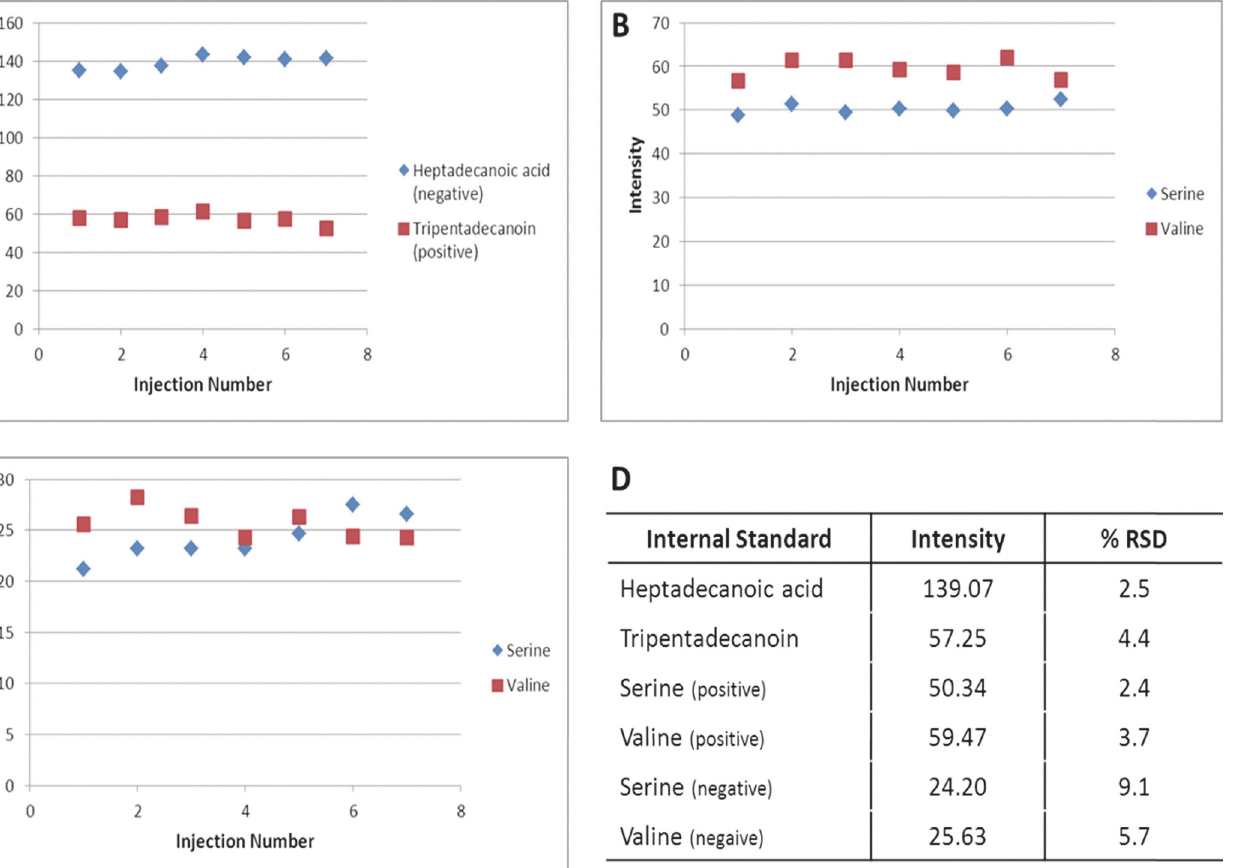
PLOS ONE | DOI:10.1371/journal.pone.0122883 April 8,